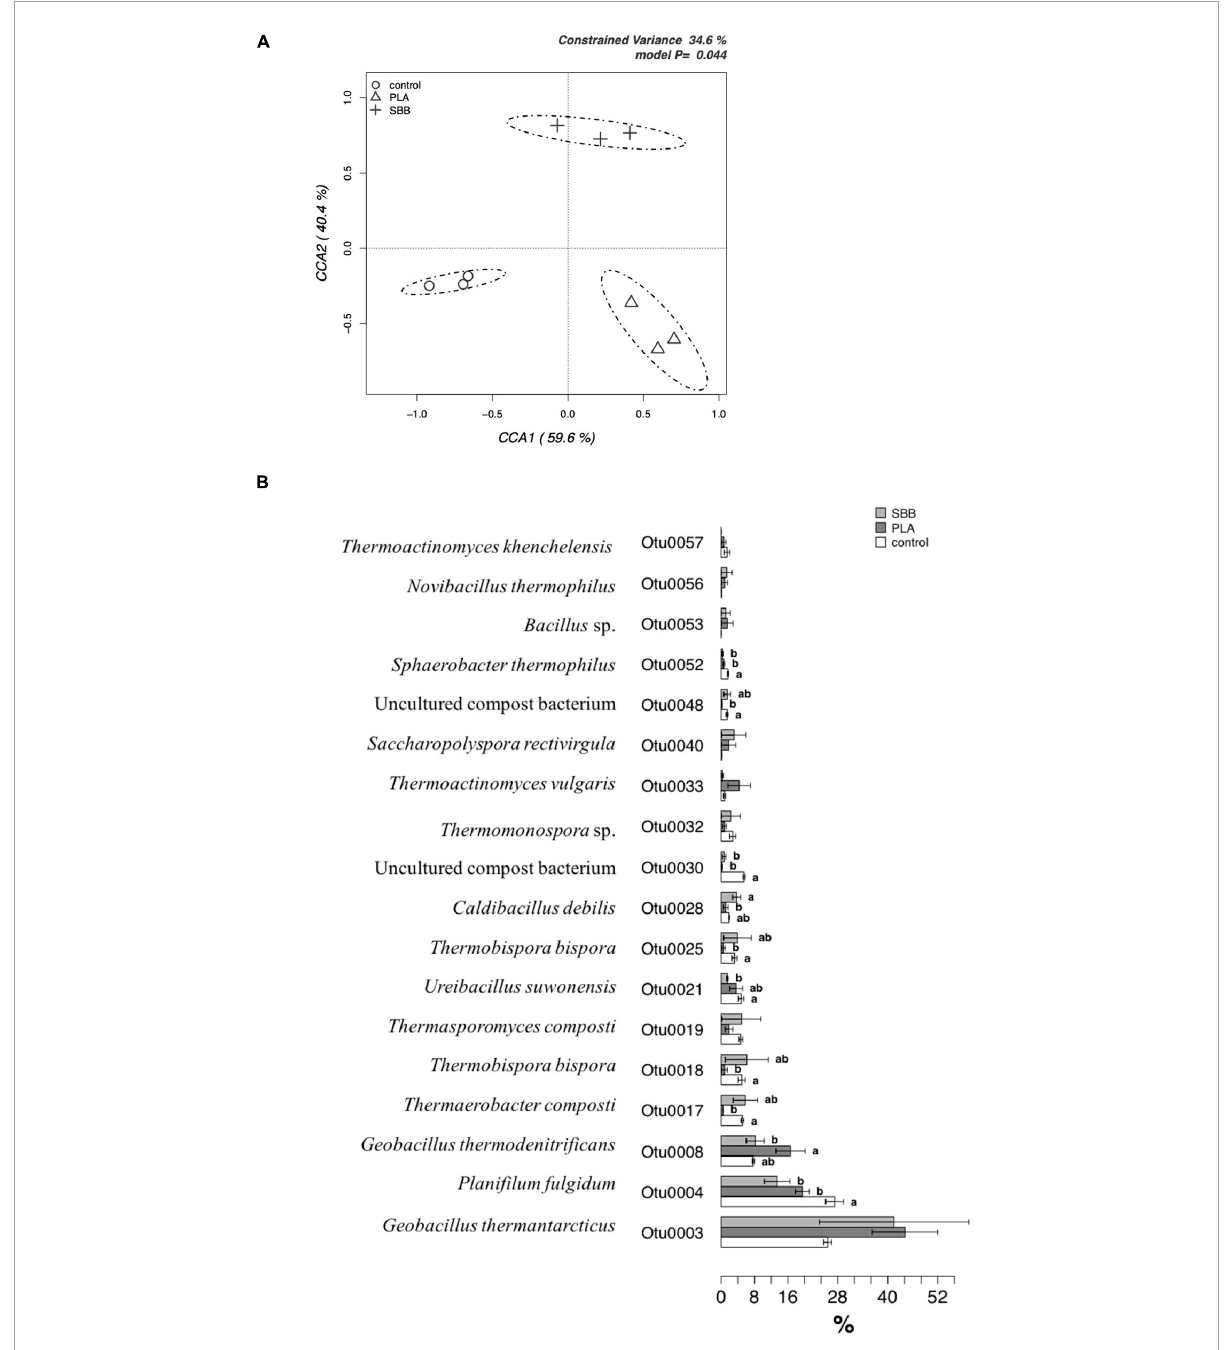
FIGURE7 The bacterial community in compost. (A) Hypothesis-driven canonical correspondence analysis (CCA) model performed on the total bacterial OTUs relative abundance data from composts of each treatment (OFMSW, control; PLA; SBB). (B) Metastats model on the relative abundances of genera comprising 99.9% of each treatment’s bacterial diversity in composts (OFMSW, control; PLA; SBB). OTUs showing significant differences according to the false discovery rate correction are highlighted with letters. PLA, polylactic acid; SBB, starch-based bioplastic; OFMSW, organic fraction of municipal solid